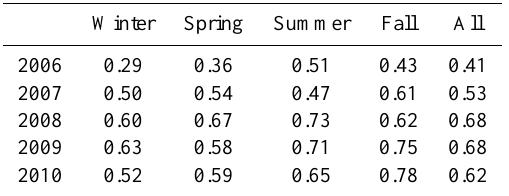
Table 2. Fraction of data coverage of the CO 2 fluxes for each season and year